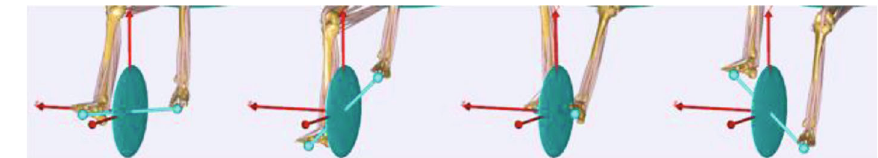
Figure 2: Variation in crank angles during movement.